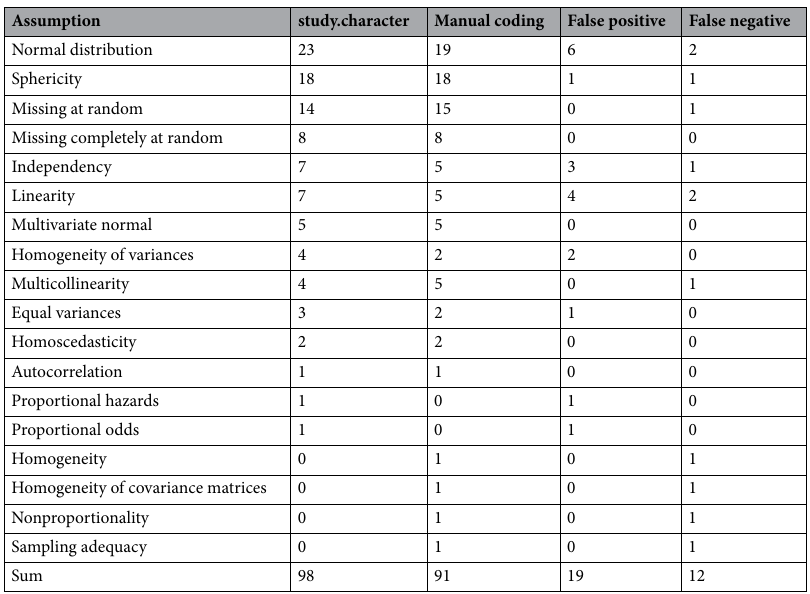
Table 11. Absolute frequencies of detected statistical